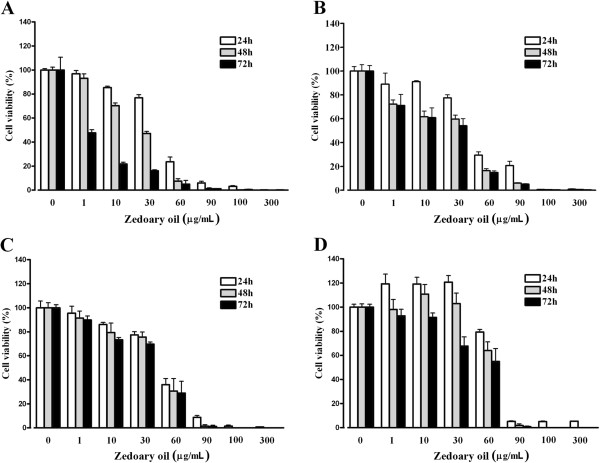
Effects of zedoary oil on the viability of gastric cancer cells and normal gastric epithelial cells. (A) AGS cells were treated with zedoary oil without FBS for 24, 48 and 72 h. (B) AGS cells were treated with zedoary oil containing 3% FBS for 24, 48 and 72 h. (C) MGC 803 cells were treated with zedoary oil containing 3% FBS for 24, 48 and 72 h. (D) GES-1 cells were treated with zedoary oil containing 3% FBS for 24, 48 and 72 h. Data represent means ± SD (N = 3).